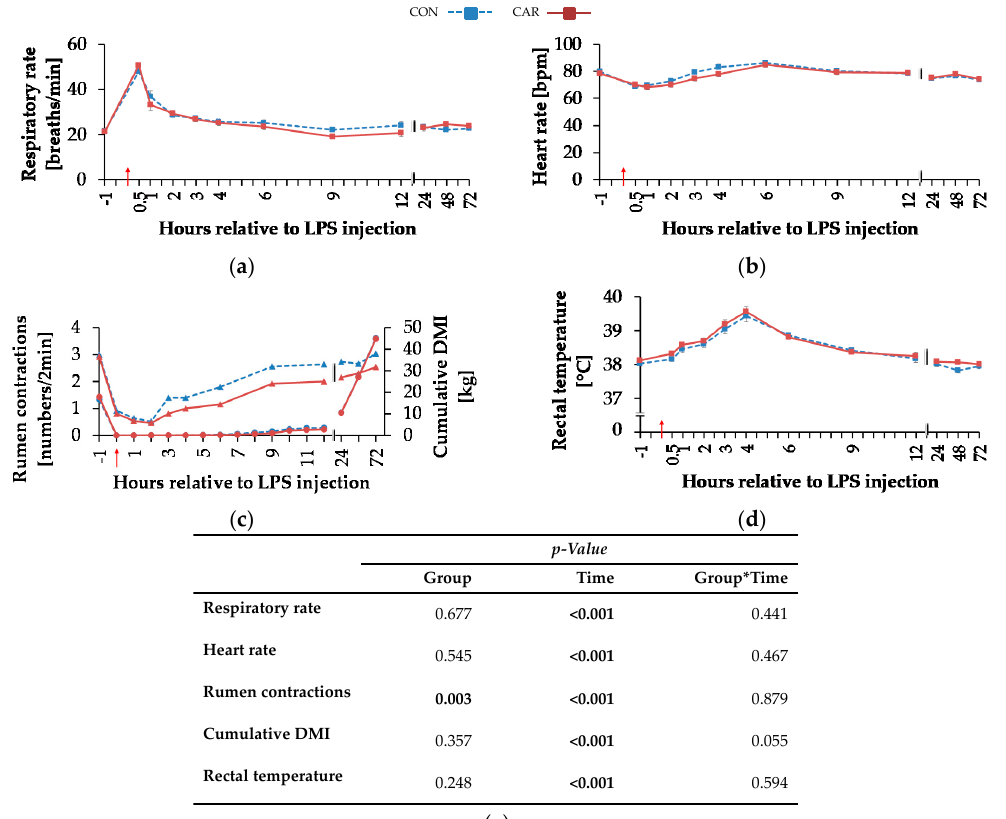
Figure 3. Progression of clinical parameters and cumulative dry matter intake of dairy cows fed a non-supplemented (CON) or an L-carnitine supplemented diet (CAR, 25 g/d from 6 weeks ap up to day 126 pp) before and after an intravenous injection of 0.5 μ g/kg BW lipopolysaccharides (LPS) on day 111 pp (red arrow). ( a ) Respiratory rate ( b ) heart rate, ( c ) primary rumen contractions (triangles, left ordinate) and cumulative dry matter intake (DMI) (circles, right ordinate), ( d ) rectal temperature, ( e ) data statistics. Data are given as LS-Means standard errors. Significant p -values are marked as bold.